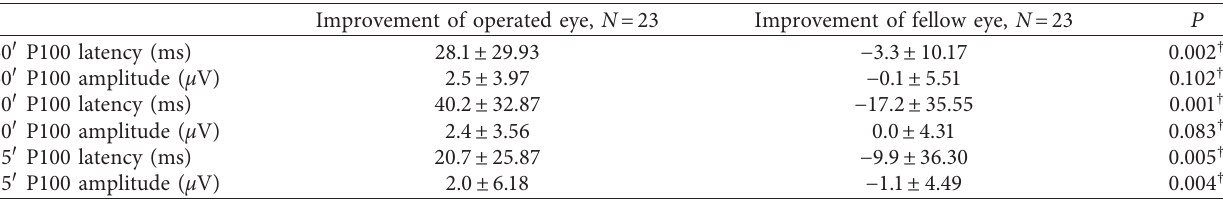
Table 7: Improvement of visual evoked potential parameters of the operated eyes and fellow eyes after treatment in patients with bilateral DON.